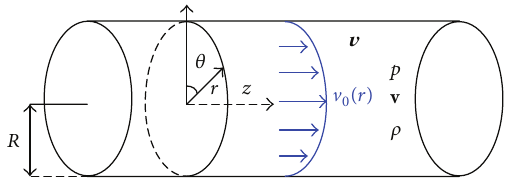
Figure 1: (Color online) Configuration of the cylindrical coordinate system (the flow profile is assumed to be